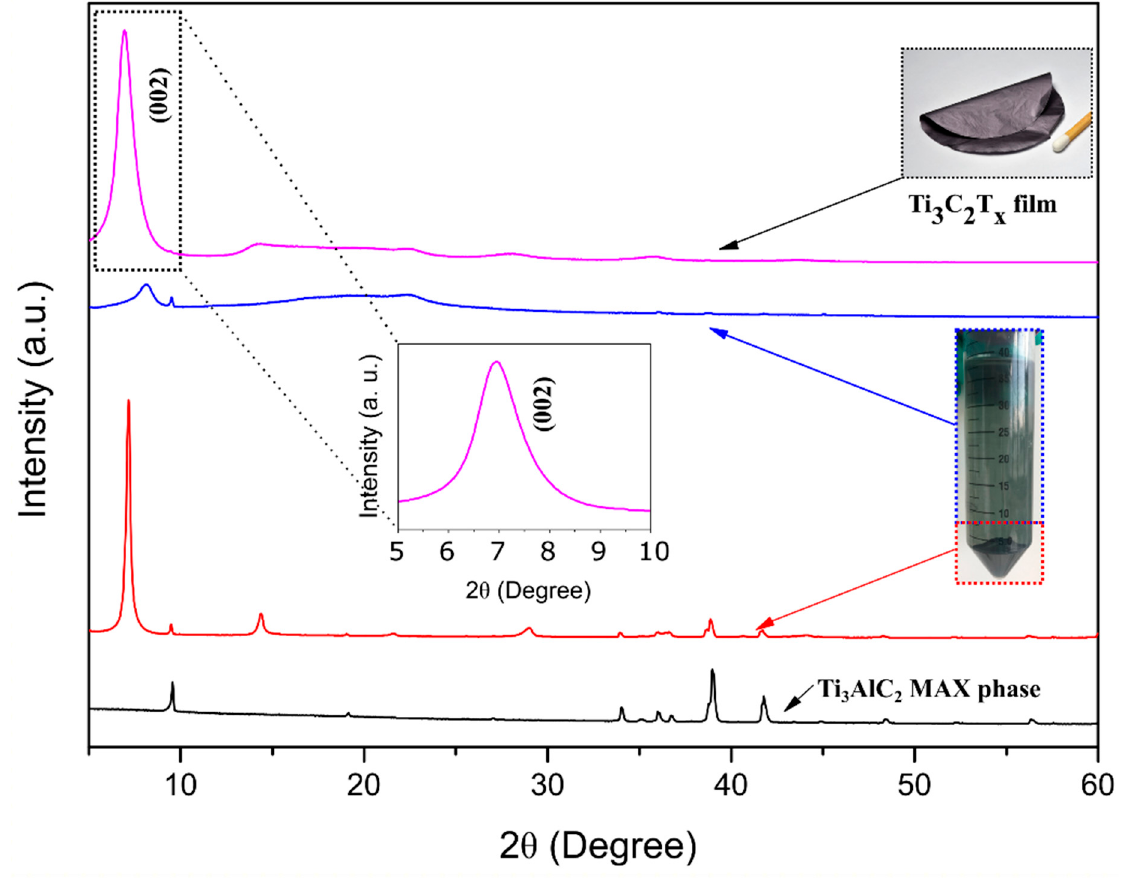
Figure 1. XRD patterns of the MAX (Ti 3 AlC 2 ) powder (black), the slurry (red) and suspension (blue) after the third centrifugation cycle and the Ti 3 C 2 MXene free-standing membrane (pink).